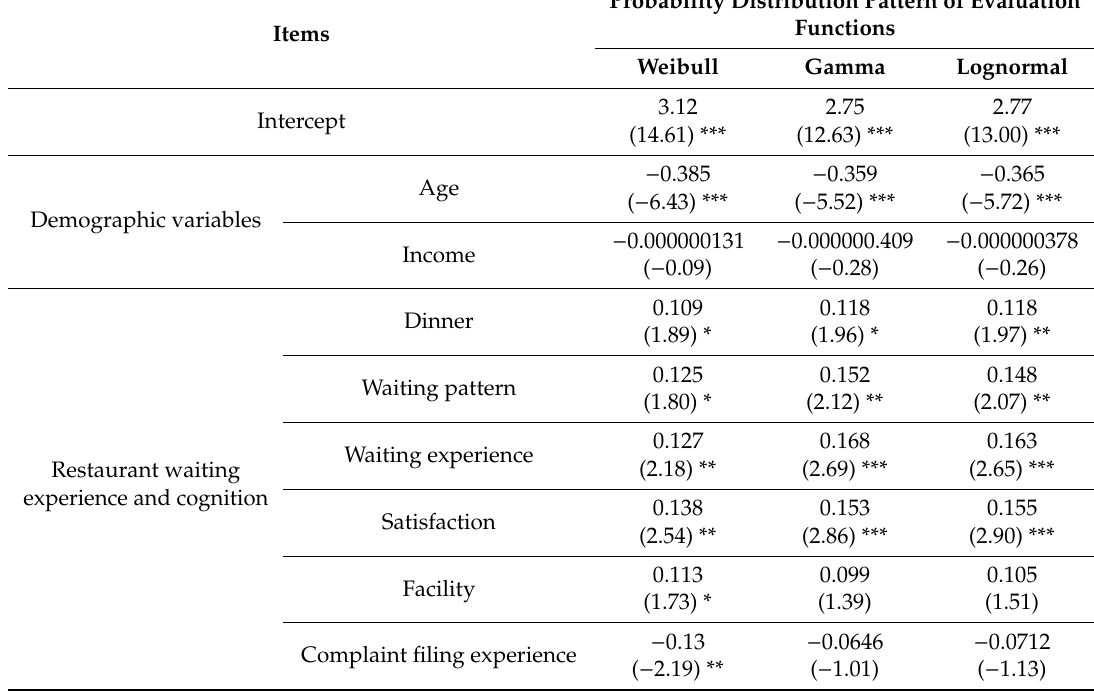
Table 6. Estimated results of the WTW function for tangible service